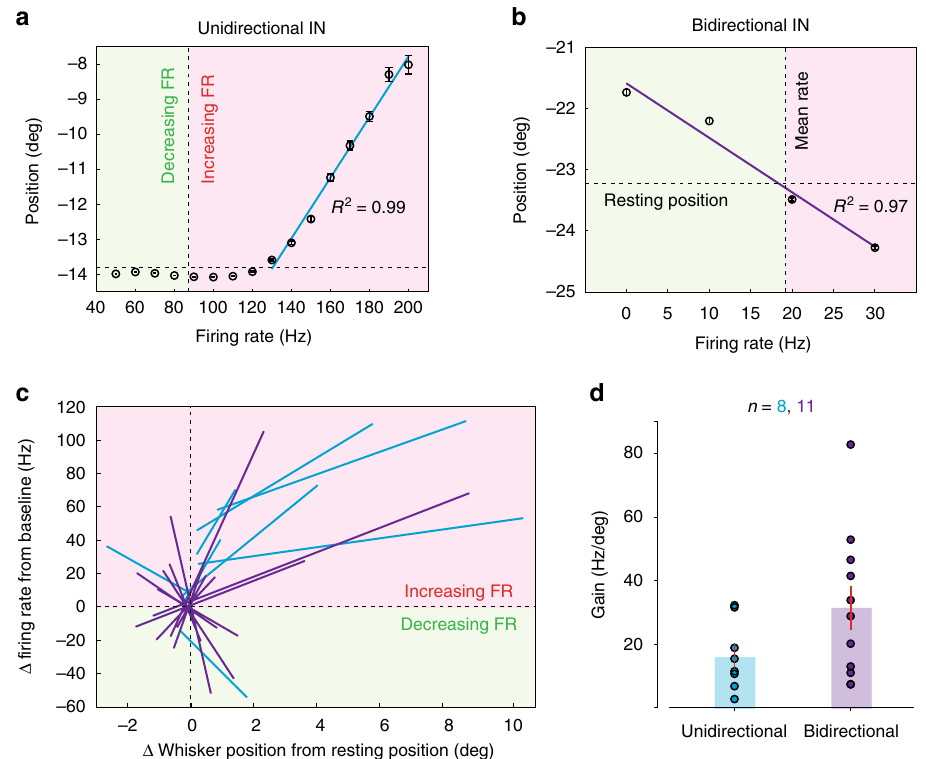
Fig. 7 Linear relationships between inhibitory interneuron fi ring rates and whisker position. a . Example of unidirectional IN demonstrating piece-wise linear relationship between instantaneous fi ring rate and mean whisker position. Linear regression (in blue , R 2 = 0.99, Degrees of freedom = 7, F -test = 526.1, P < 0.001, ANOVA) was performed over the range of fi ring rate modulation by whisking (protraction in this case). Vertical dashed line indicates the cell ’ s baseline rate during non-whisking. Red and green shading represent increase and decrease in fi ring rate, respectively. Horizontal dashed line shows the resting position of whisker. b Example of bidirectional IN. Linear fi t (in purple , R 2 = 0.97, Degrees of freedom = 3, F -test = 70.8, P < 0.05, ANOVA) encompassing both directions of whisker movement. This cell decreased fi ring rate when the whisker was in the protraction side and increased rate while whisker moved in the retraction side. c . Summary of all unidirectional ( blue , n = 8) and bidirectional ( purple , n = 11) INs that demonstrated signi fi cant linear correlations between fi ring rate and whisker position ( R 2 = 0.96 ± 0.01, n = 19; P < 0.05, ANOVA). Relative changes in fi ring rate and whisker position were normalised with respect to each cell ’ s spontaneous rate during non-whisking and the resting position of whisker, respectively. d Gain (Hz/deg), de fi ned as the absolute value of the slope of individual linear regressions in c . for two types of INs ( P = 0.12, Mann – Whitney U